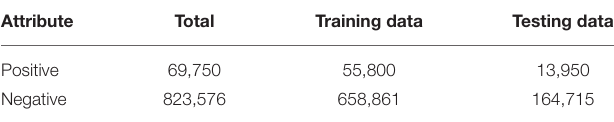
TABLE 1 | Distribution of experimental data sets.